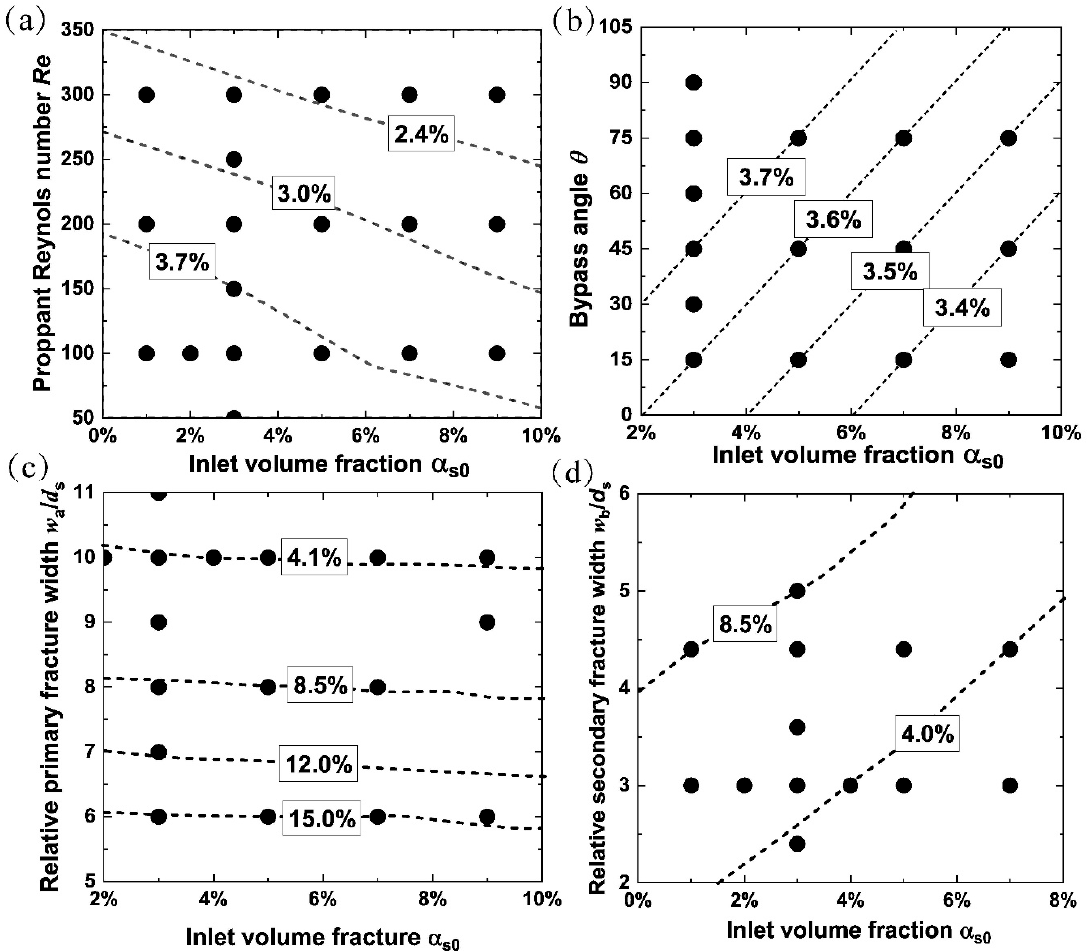
Figure 8. The contour map of RPM relating to the dimensionless parameters, ( a ) inlet proppant volume fraction and the proppant Reynolds number, ( b ) inlet proppant volume fraction and the bypass angle, ( c ) inlet proppant volume fraction and the relative width of the primary fracture, ( d ) inlet proppant volume fraction and the relative width of the secondary fracture.